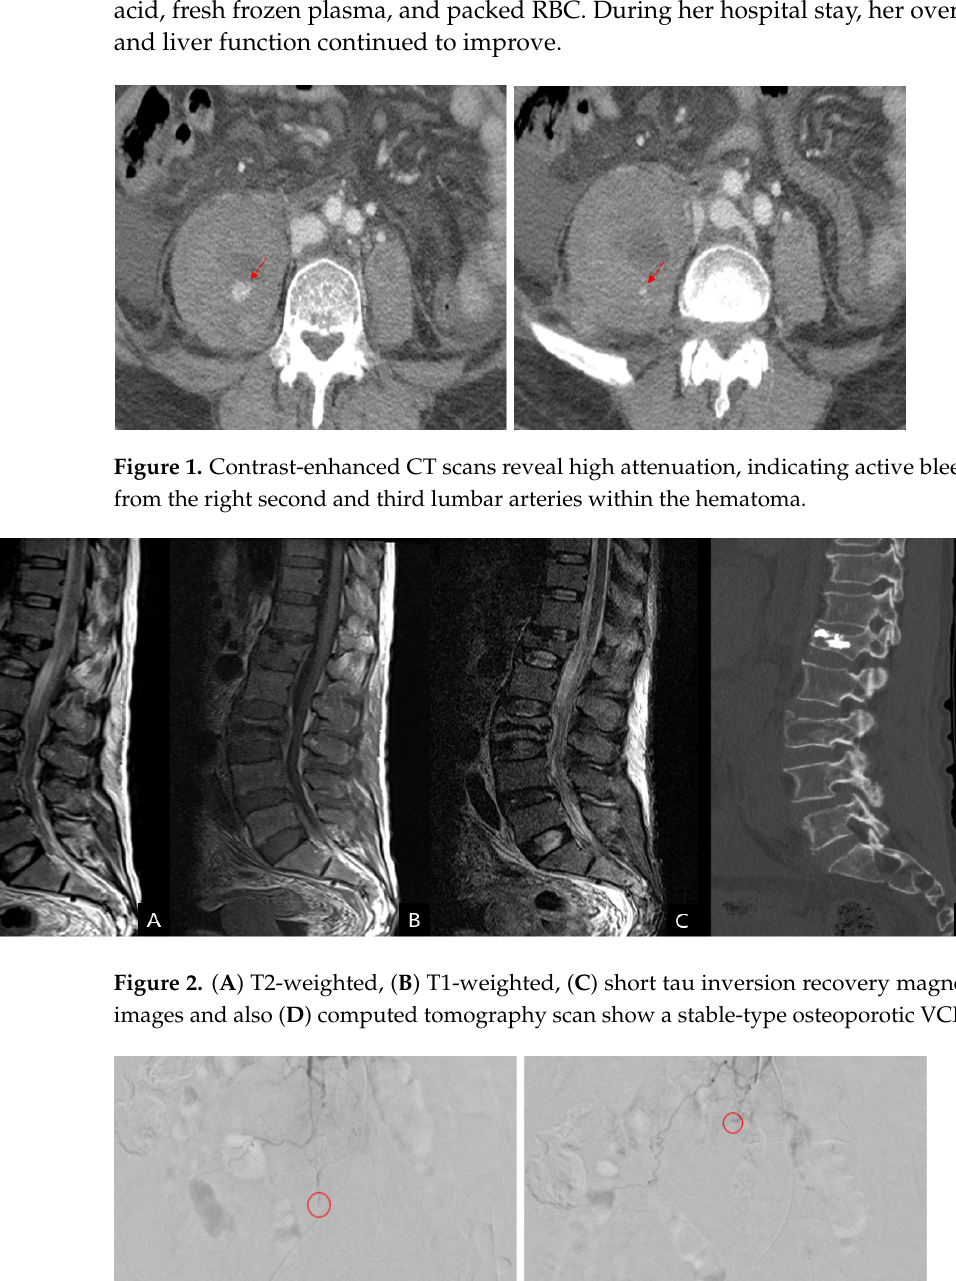
Figure 1. Contrast-enhanced CT scans reveal high attenuation, indicating active bleeding (arrows) from the right second and third lumbar arteries within the hematoma.